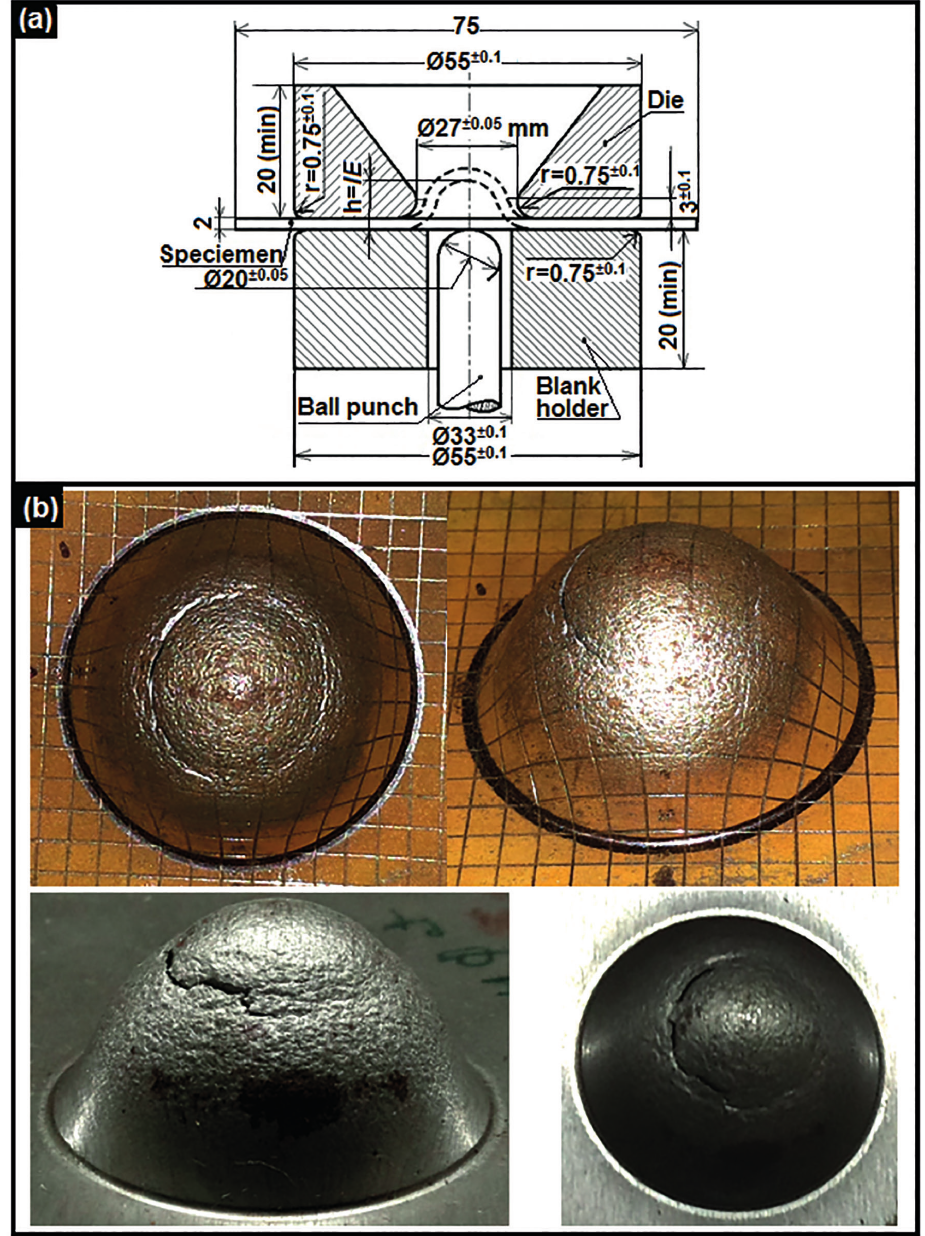
Figure 2: a) Schematic showing of Erichsen cup test arrangements; b) photo images of Erichsen cup